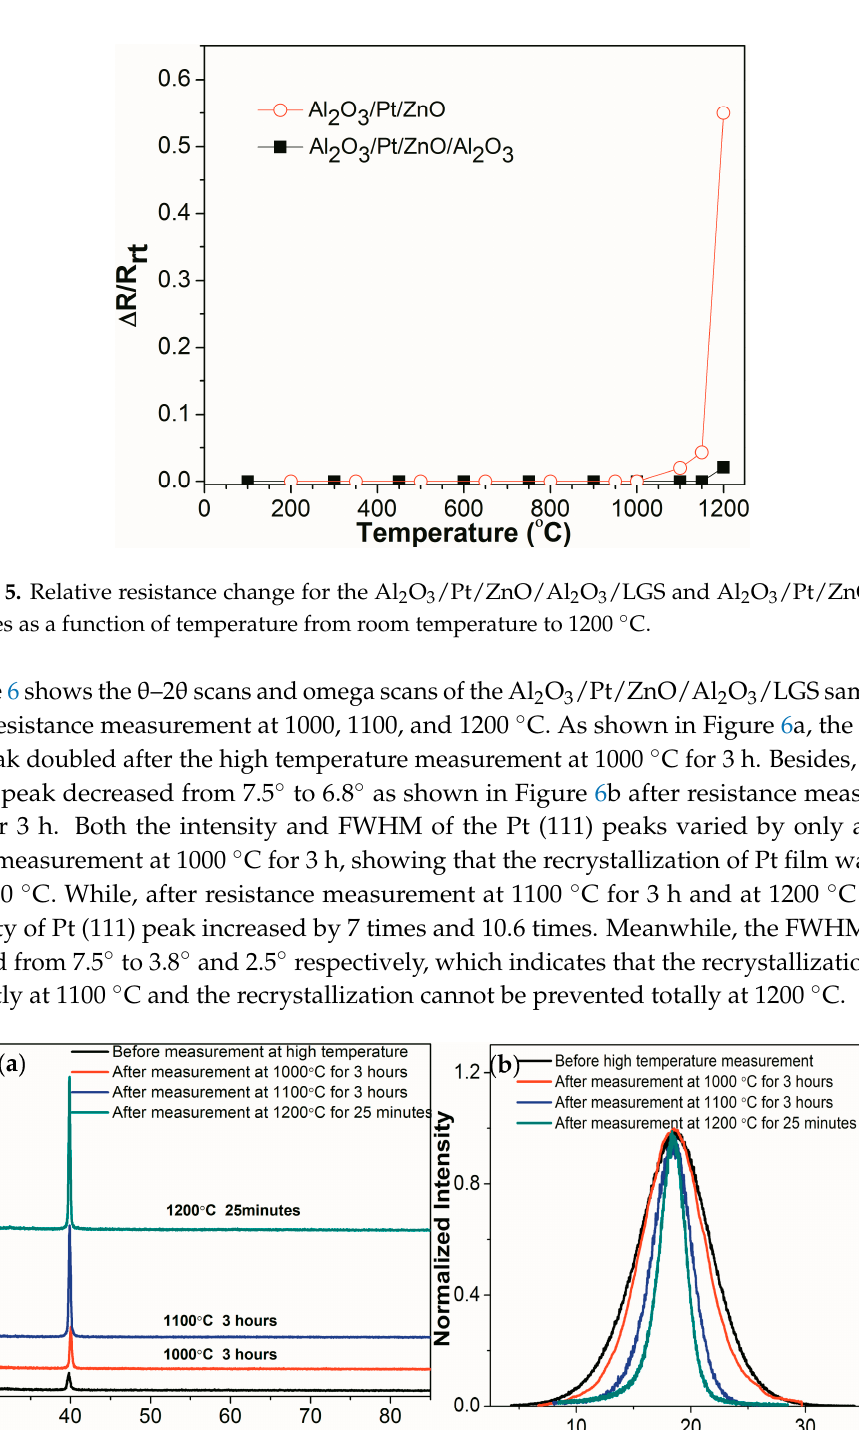
Figure 6. ( a ) θ –2 θ scans and ( b ) omega scans of the Al 2 O 3 /Pt/ZnO/Al 2 O 3 /LGS samples before and after resistance measurement at 1000 °C, 1100 °C and 1200